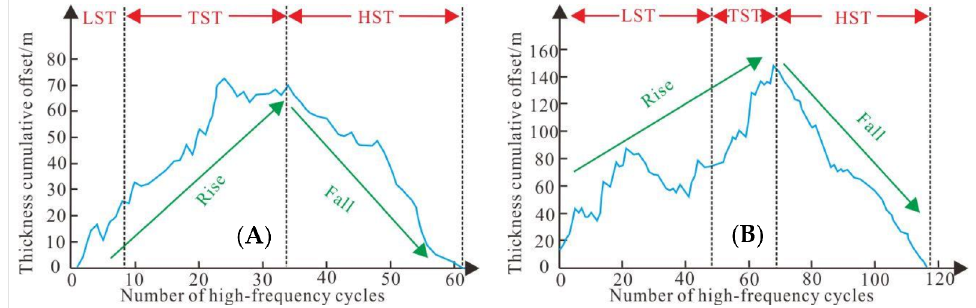
Figure 8. Fisher chart. ( A ) Well A1. ( B ) Well